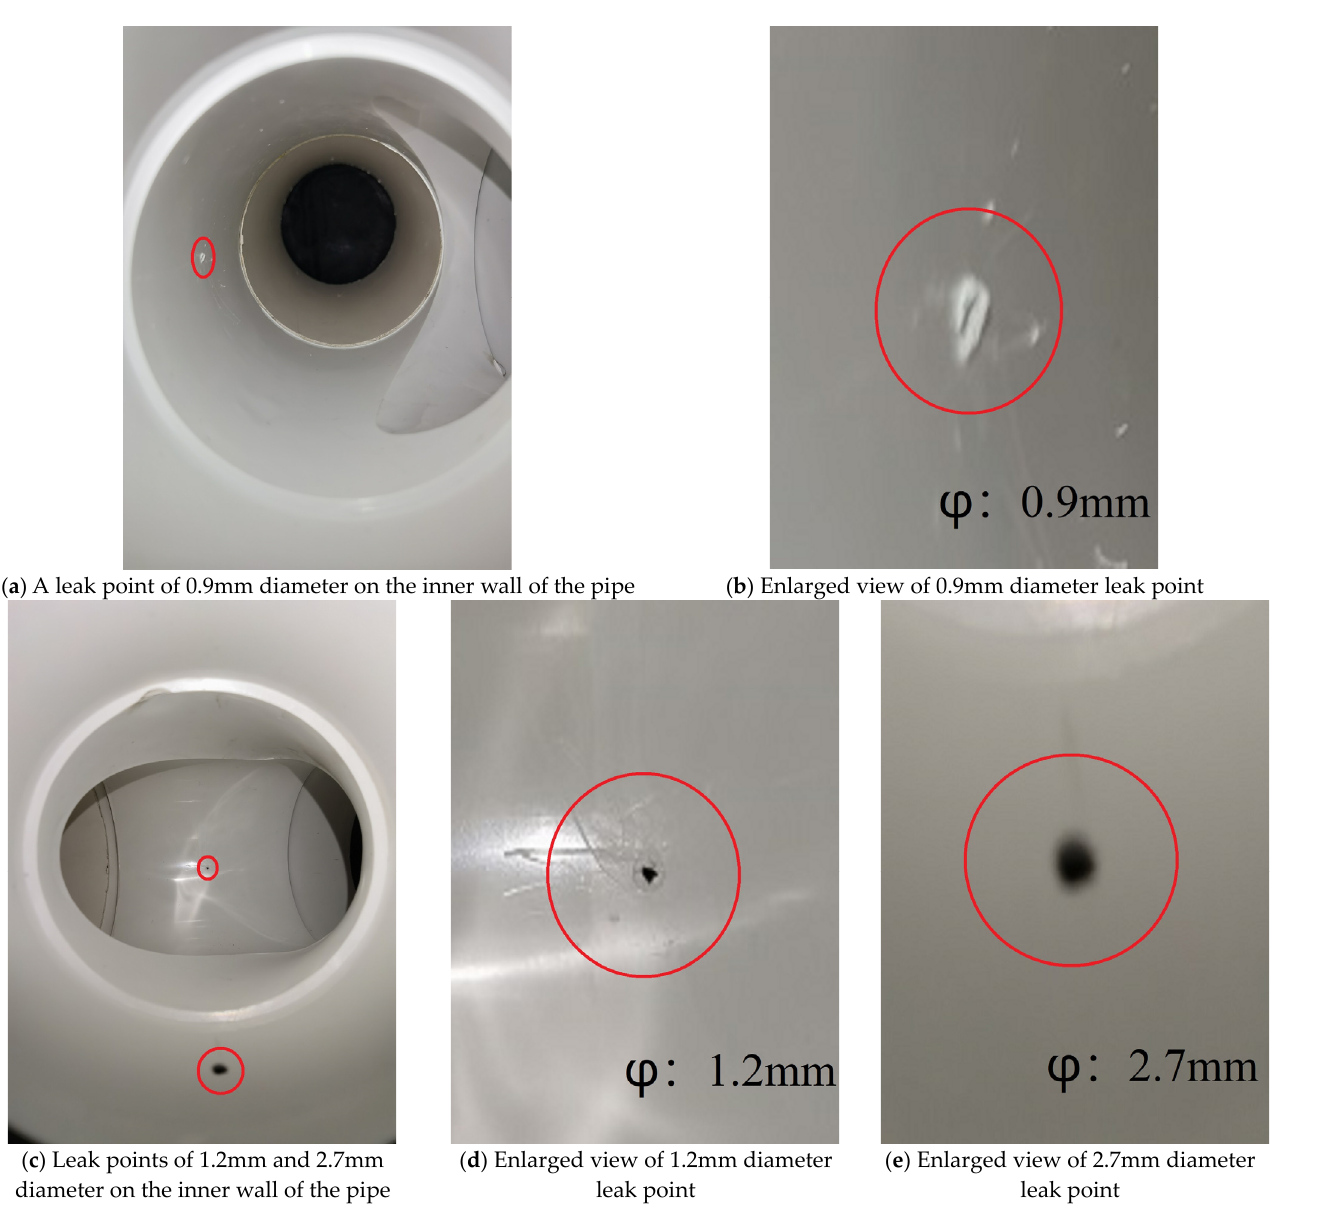
Figure 3. DN100 gas pipeline and its leakage point local enlargement.